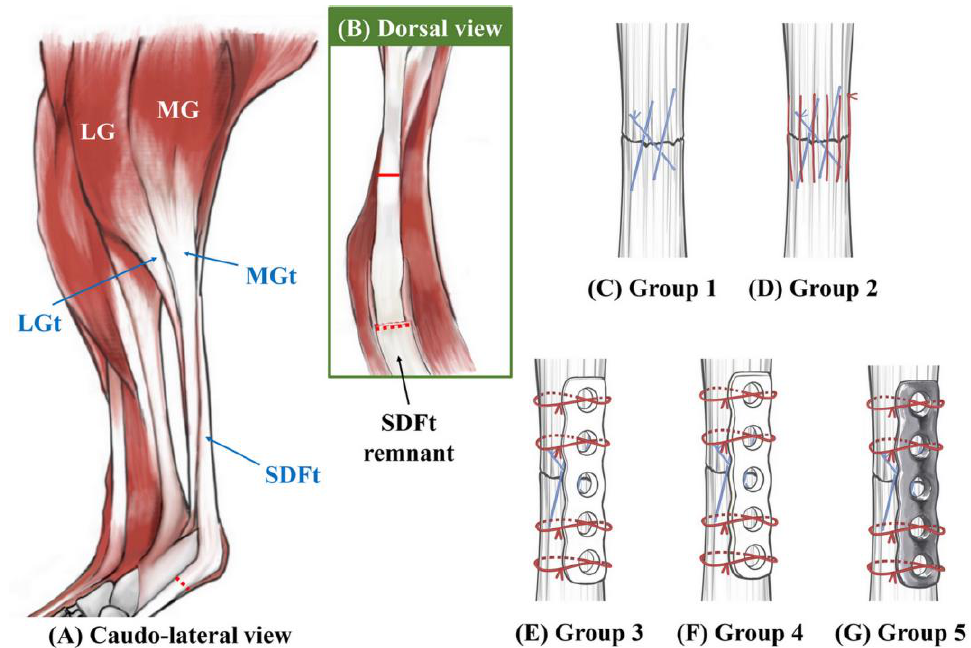
Figure 2. ( A ) Diagram illustrating the rabbit GT in a cadaveric model. ( B ) The superficial digital flexor tendon has been removed. The transected GT was repaired with a 4-0 polydioxanone suture in a three-loop pulley pattern alone ( C ) or in conjunction with an epitendinous suture ( D ), a five-hole 1-mm polycaprolactone (PCL) plate ( E ), a five-hole 2-mm PCL plate ( F ), or a five-hole 1.5-mm titanium plate ( G ). Abbreviations: LG: lateral head of the gastrocnemius, LGt = lateral gastrocnemius tendon, MG = medial head of the gastrocnemius, MGt = medial gastrocnemius tendon, and SDFt = superficial digital flexor tendon.